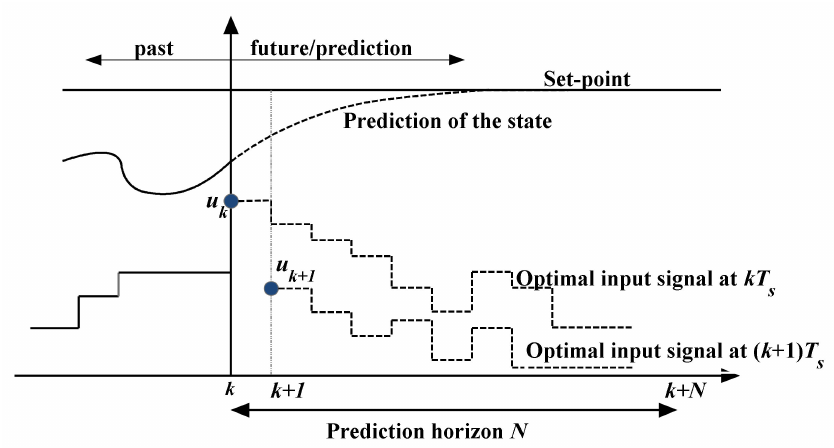
Figure 3. Receding horizon technique.